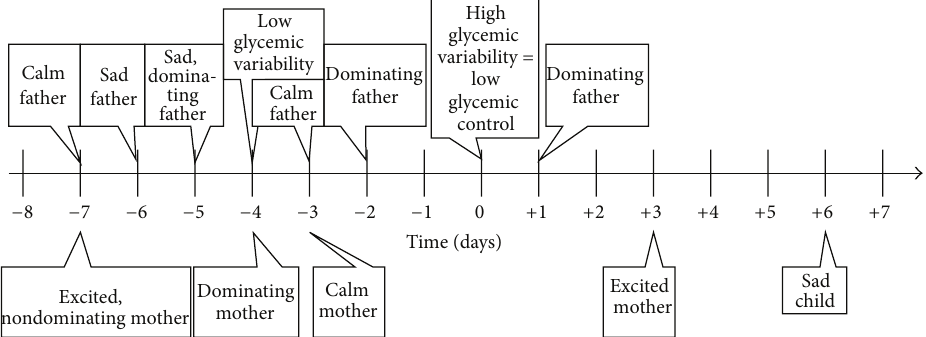
Figure 2: Timeline displaying effects correlating with poor glycemic control. The graph depicts a psychosomatic cycle in which various emotional states of all involved family members influence glycemic variability of the adolescent patient and vice